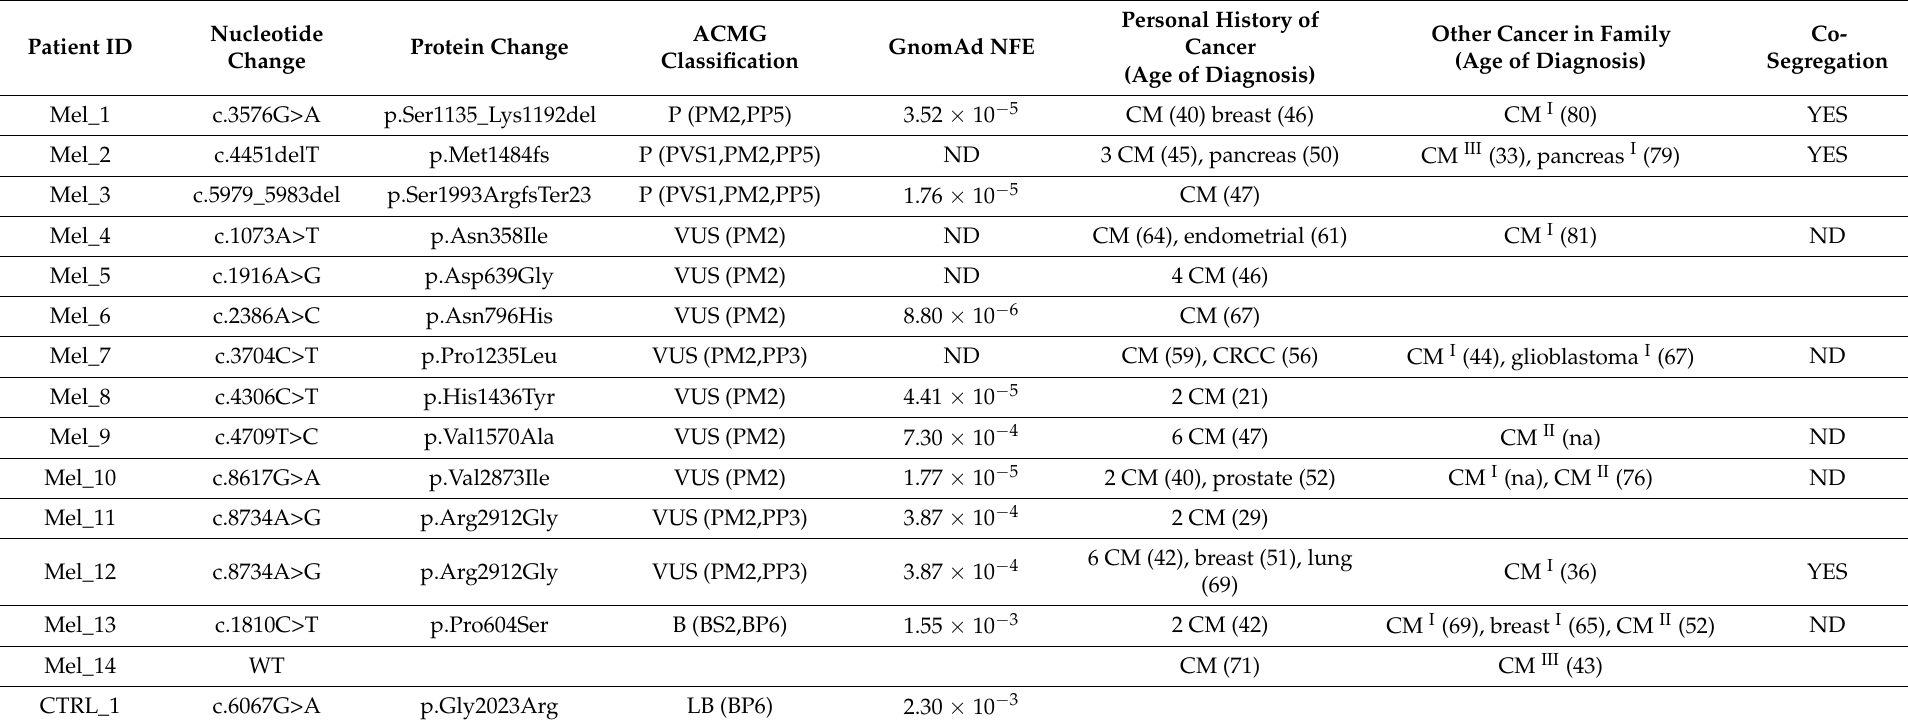
Table 1. Variants classification and clinical